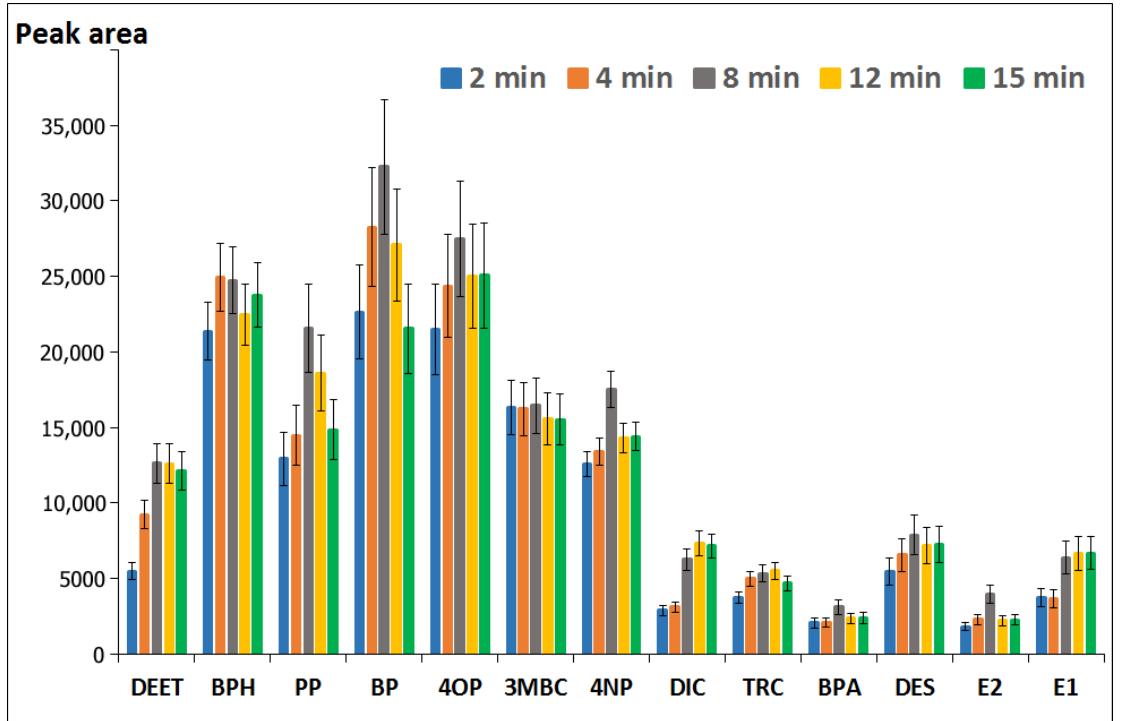
Figure 6. The influence of the extraction time on isolation efficiency.